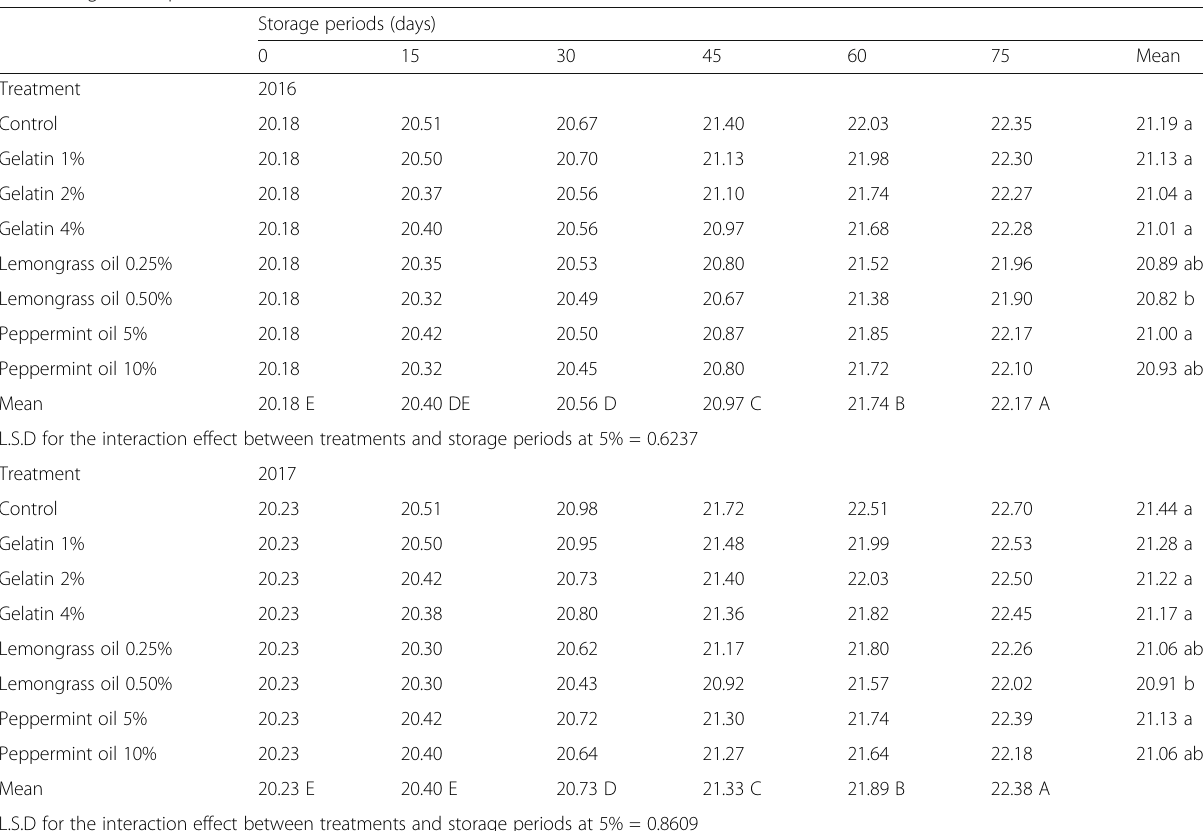
Table 5 Effect of gelatin, lemongrass oil, and peppermint oil on total sugar (g/100 FW) of Samany date palm fruits stored at 0.0 ± 2 °C during two experimental seasons Storage periods